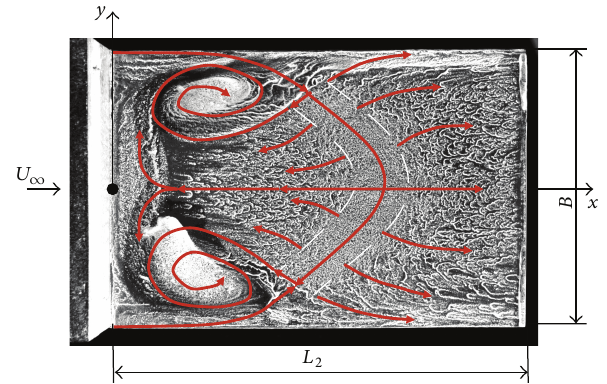
Figure 5: Flow pattern on the SFS flight deck